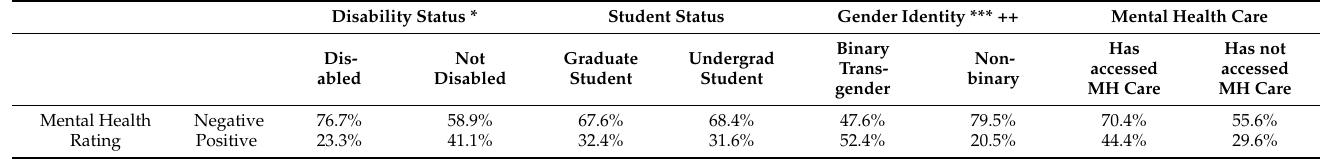
Table 4. Mental health ratings by student disability status, student status, gender identity, and mental health care 1,2